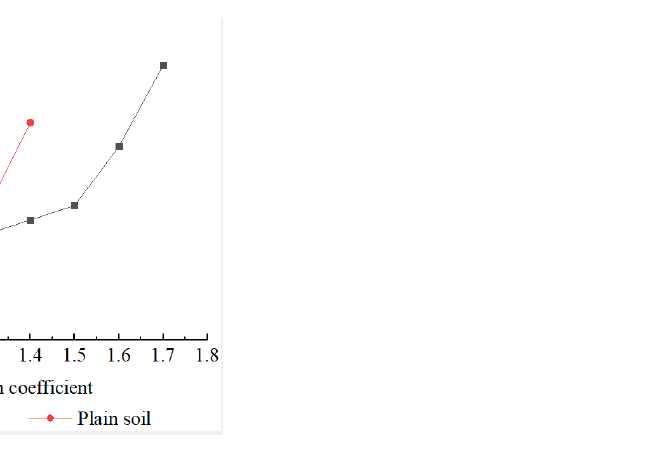
Figure 4. Extreme values of displacement in the x-direction of embankment slope with different reduction coefficients.